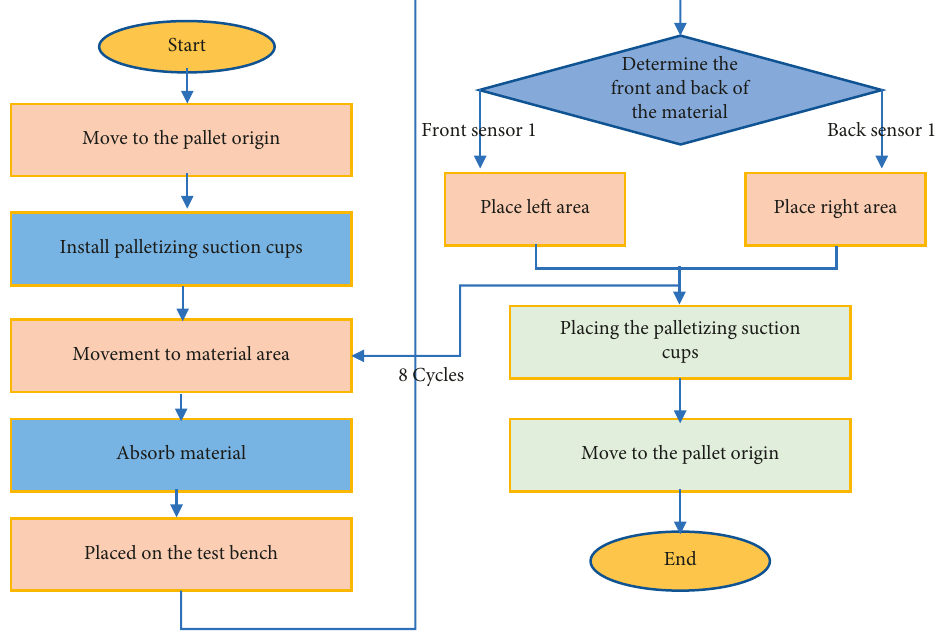
Figure 5: Palletizing